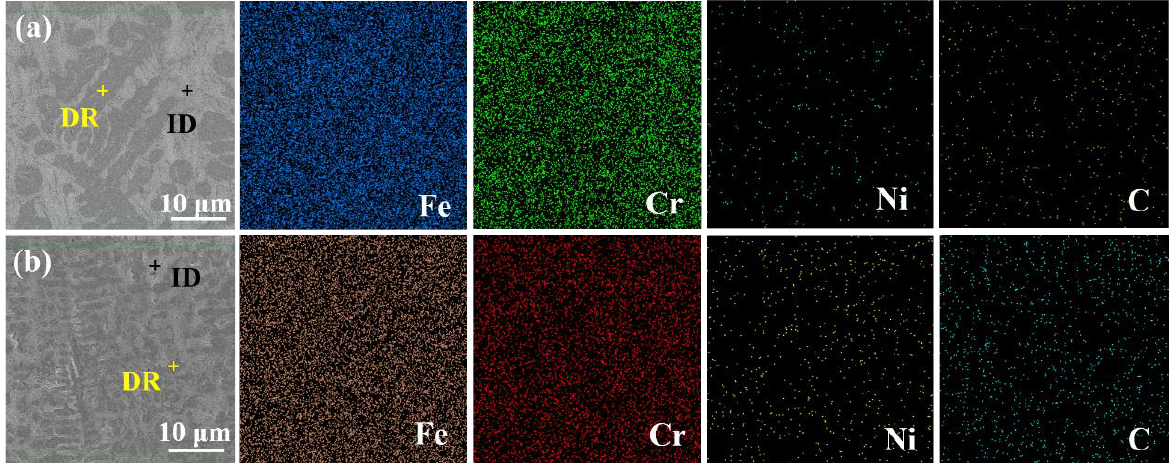
Figure 4. EDX of laser cladding coatings of ( a ) 1# and ( b ) 2#. Table 3. EDS analysis results of coatings (at.